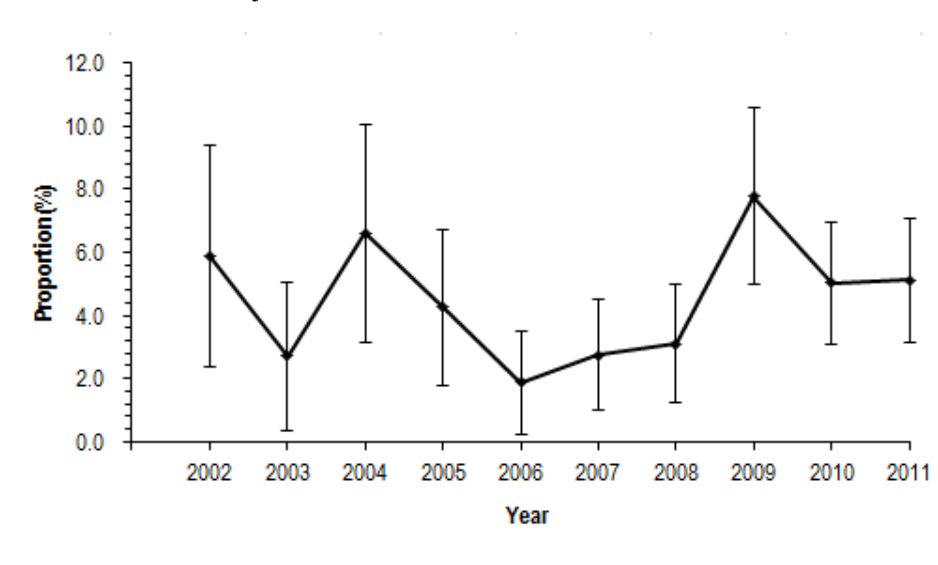
Figure 2. Year trend of proportion of suspected AHT in all inpatient children 0–4 years of age with traumatic brain